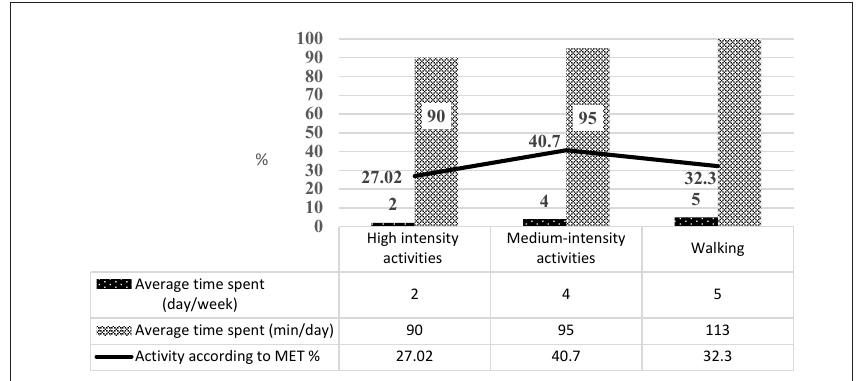
Figure 3. Distribution of respondents according to the average physical activity intensity indicators in the group of high FA level